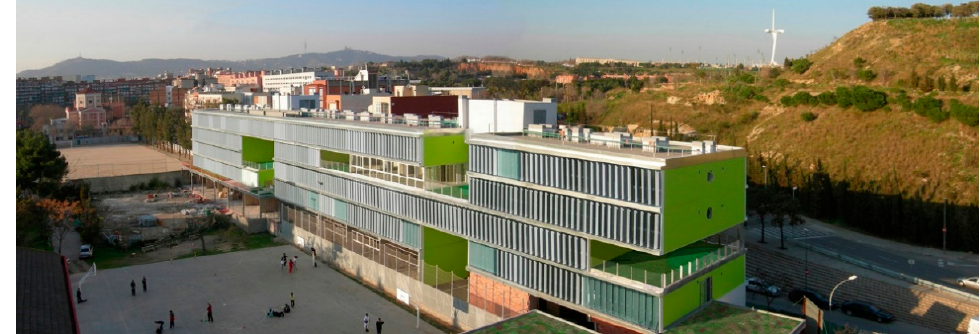
Figure 5. Mare de Deu housing block, Barcelona, Spain, by Blanca Lleó. © Blanca Lleó .